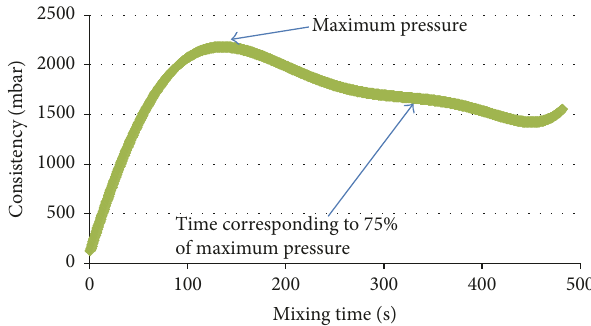
Figure 1: Curve from the consistograph: dough consistency versus mixing time. The mixing time chosen in this work is